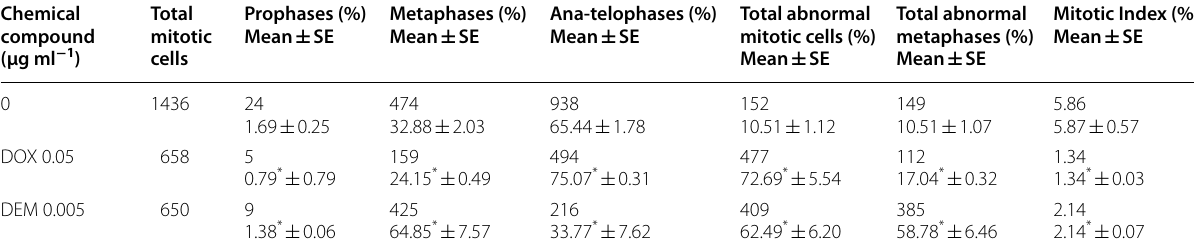
C cells treated with doxorubicin 2 12